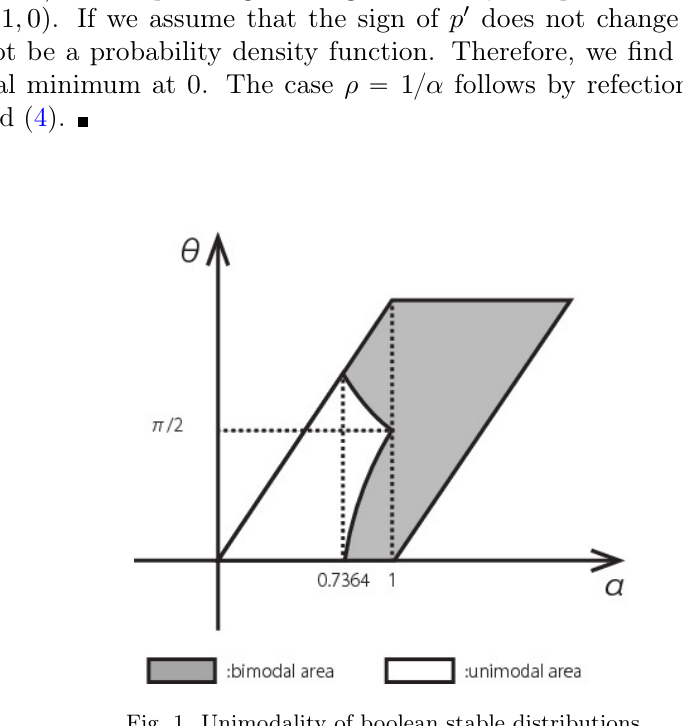
Fig. 1. Unimodality of boolean stable distributions